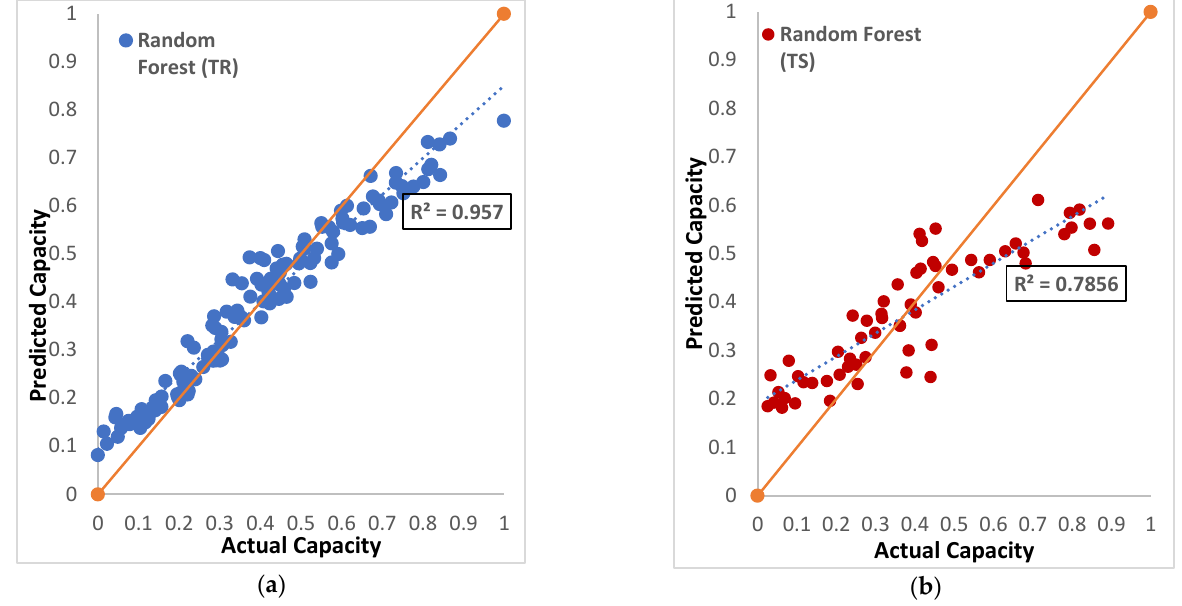
Figure 8. Trend for actual capacity and predicted capacity for RF model: ( a ) training data; ( b ) testing data.